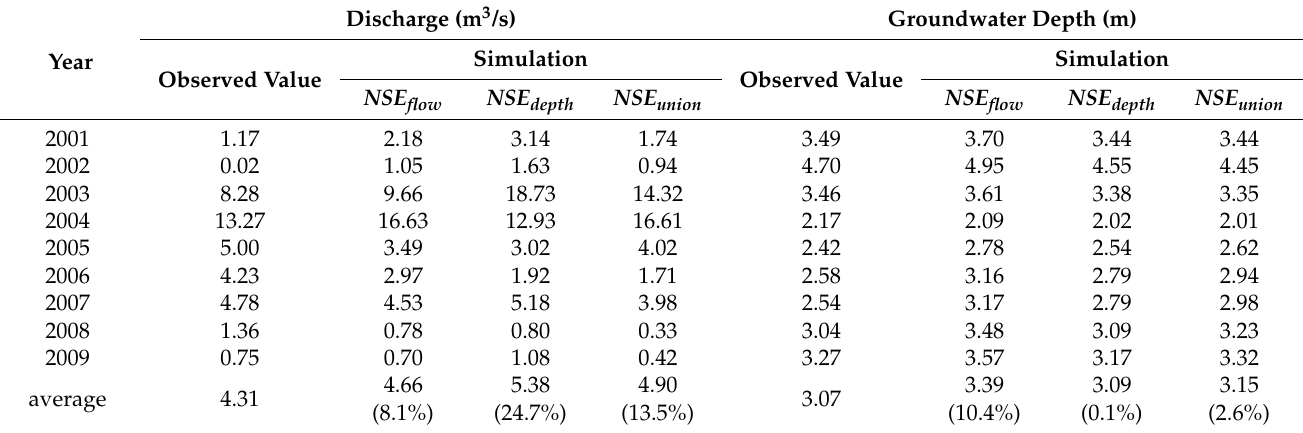
Figure 4. Comparison of the observed and simulated processes of ( a ) the river discharge and ( b ) the groundwater depth under maximizing the single-objective function NSE depth. Table 3. Comparison of the simulated and observed results of the discharge and the groundwater depth from 2001 to